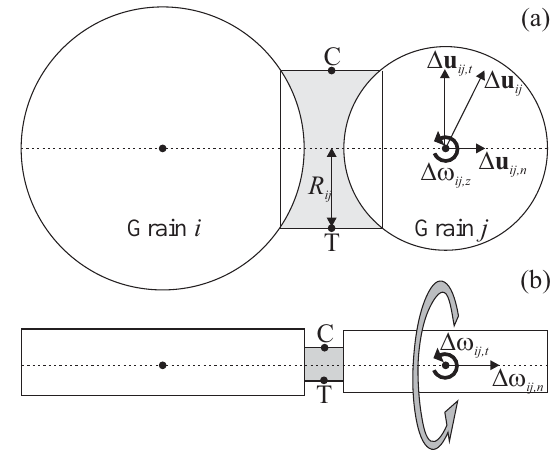
Figure 3. Forces and torques acting on an elastic bond connecting grains i and j : top view (a) and side view (b) . Letters C and T de- note points where maximum compressive and tensile stress, respec- tively, occurs due to the bending moment caused by (cid:49)ω ij,z in (a) and (cid:49) ω ij,t in (b) . Gray curved arrow in (b) denotes the twisting moment associated with (cid:49) ω ij,n